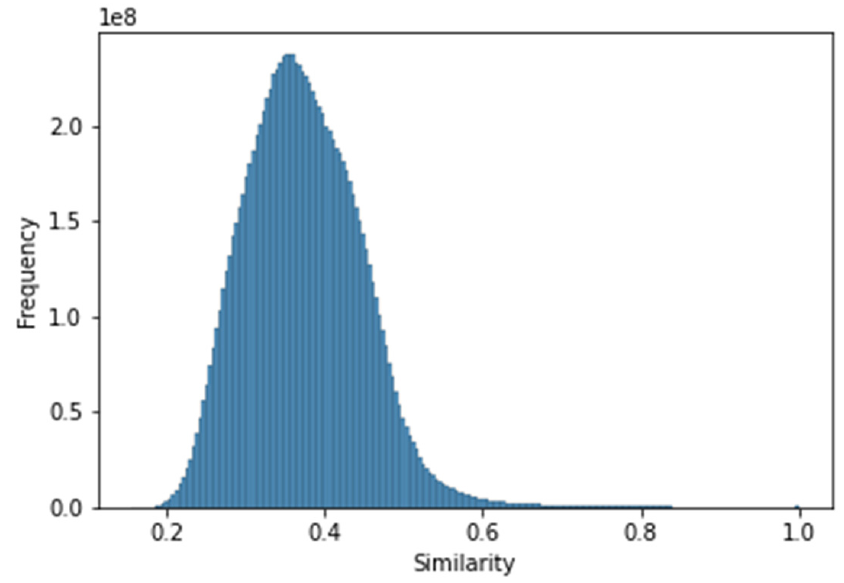
Figure 4. Histogram of similarity between compounds for the 5-HT1A curated database. The distribution of Tanimoto similarities supports the claim that the molecules present in the database were well